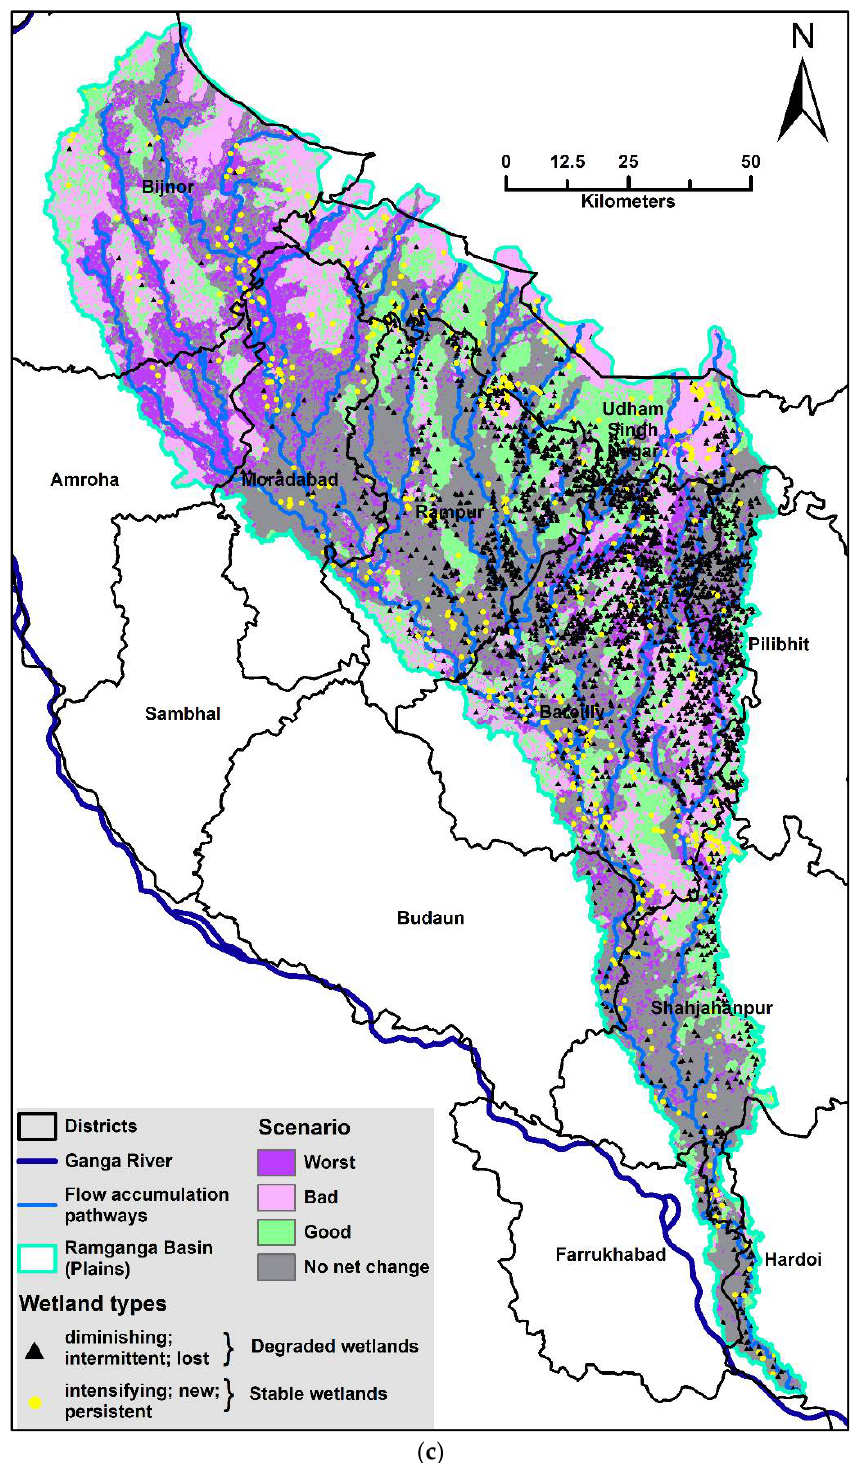
Figure 4. ( a ). Overall upslope connectivity trend. The centroids of floodplain wetlands are also plotted. ( b ). Overall downslope connectivity trend between 1994–2019 represented by increasing and decreasing CRU types. The centroids of floodplain wetlands are also plotted. ( c ). Overall scenario of wetland existence as a result of upslope (Figure 4a) and downslope (Figure 4b) connectivity trend between 1994–2019.